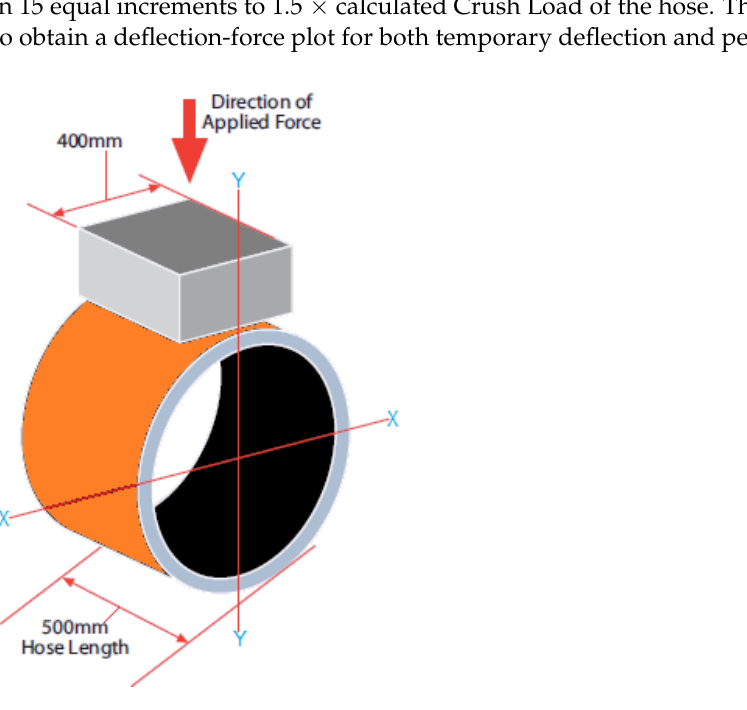
Figure 27. Depiction of crush load test on